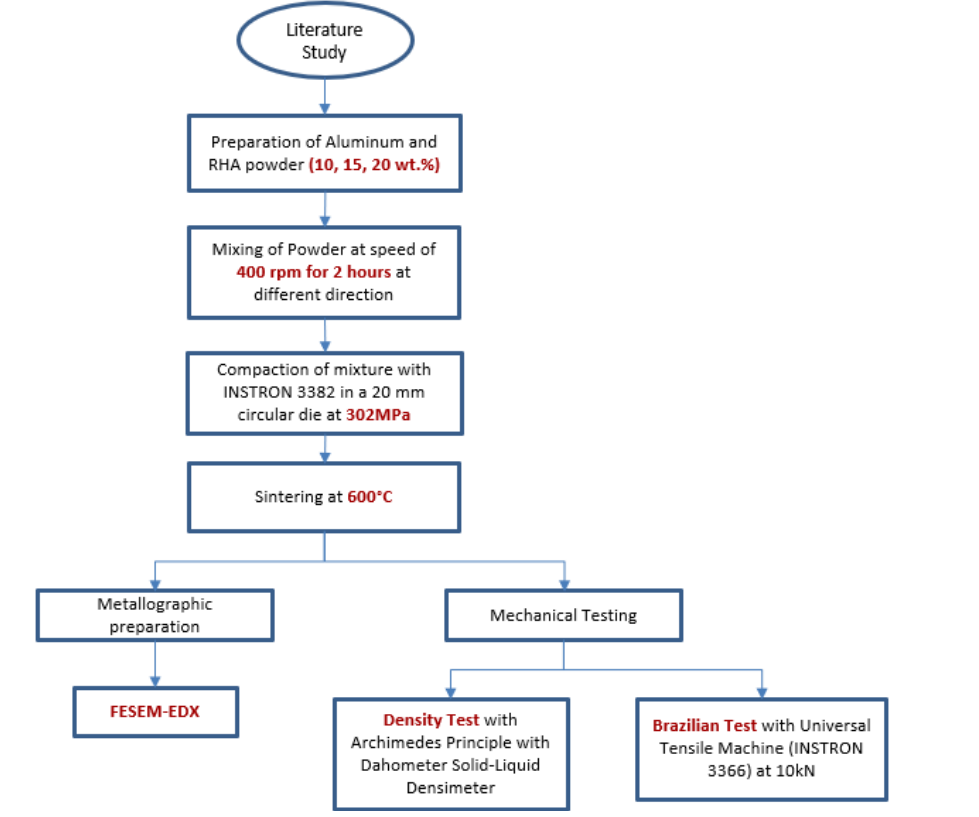
Figure 2. Complete flow chart of the study.